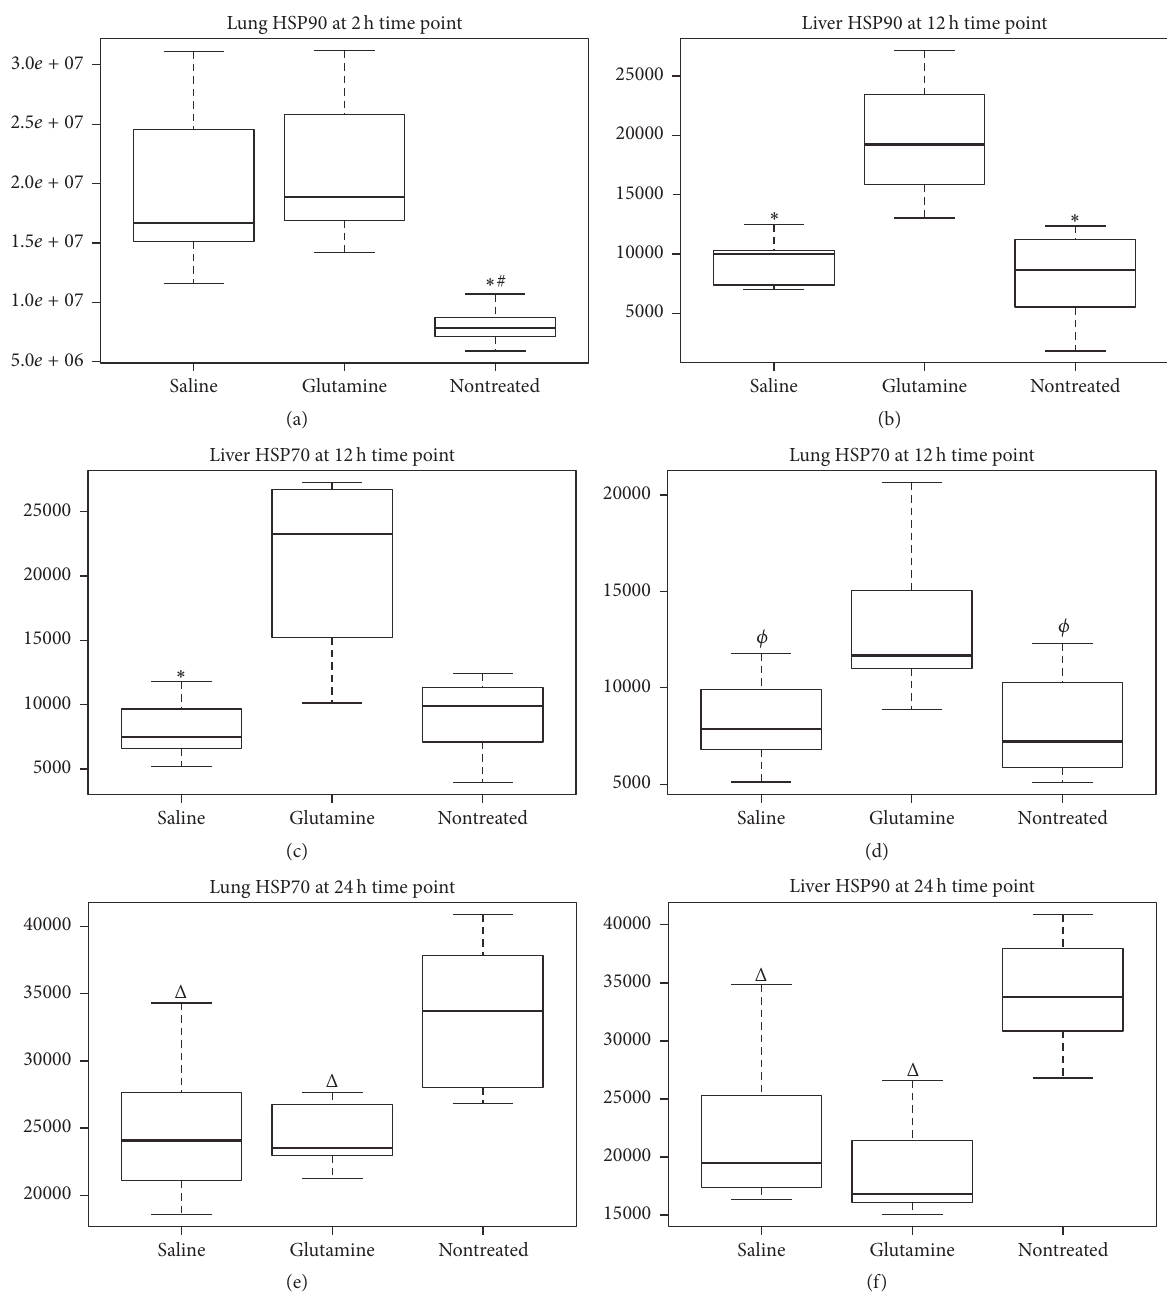
Figure 2: Lung and liver expression of heat shock proteins (HSPs) at different time points after acute pancreatitis induction with sodium taurocholate in Lewis rats previously treated or not treated with 48 h infusion of parenteral saline or glutamine. (a) Expression of HSP90 in lung tissue at 2 h. (b) Expression of HSP90 in liver tissue at 12h. (c) Expression of HSP70 in liver tissue at 12 h. (d) Expression of HSP70 in lung tissue at 12 h. (e) Expression of HSP70 in lung tissue at 24h. (f) Expression of HSP90 in liver at 24 h. Data are expressed as medians. ∗ 𝑝 ≤ 0.050 versus glutamine group; # 𝑝 ≤ 0.050 versus saline group; 𝜙 𝑝 = 0.066 versus glutamine group; Δ 𝑝 ≤ 0.050 versus nontreatment group.